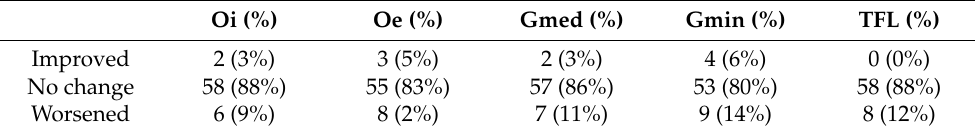
Table 5. Post-operative fatty atrophy change of each muscle.